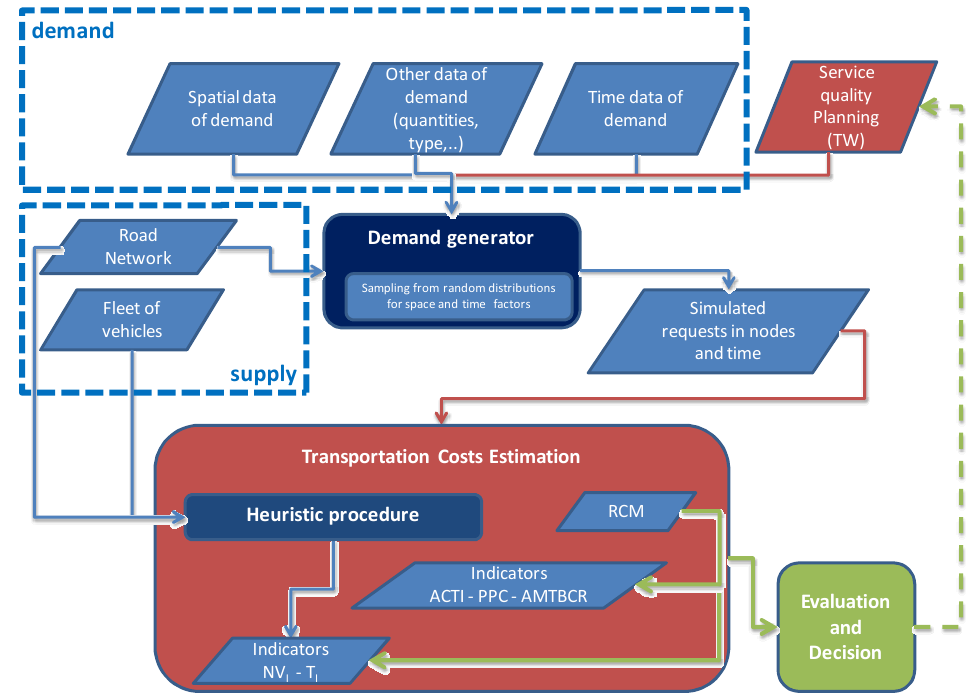
Figure 1. General framework of the evaluation